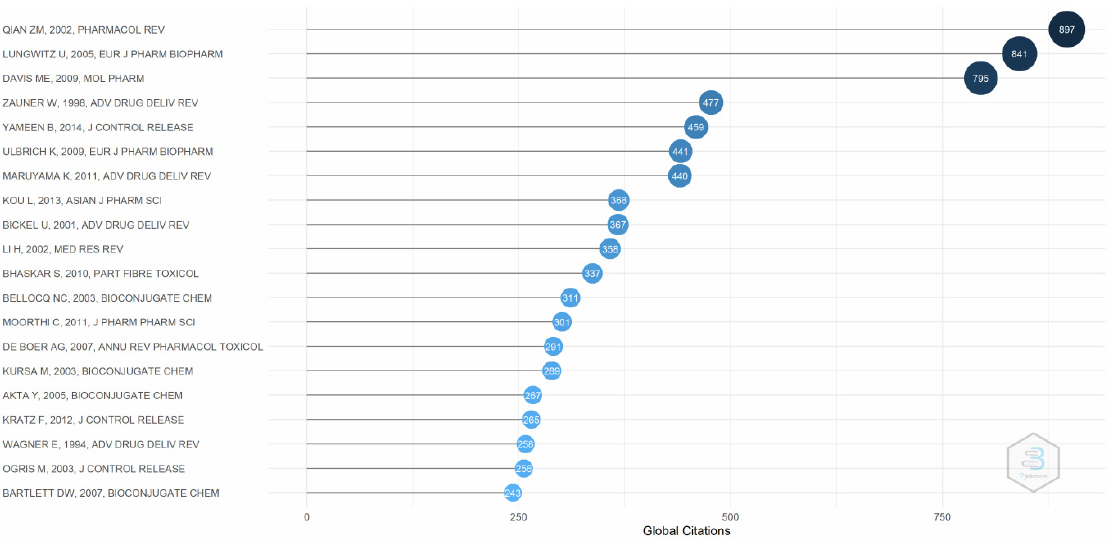
Figure 3. Global citations. Source: Authors’ elaboration using the Bibliometrix R-package.